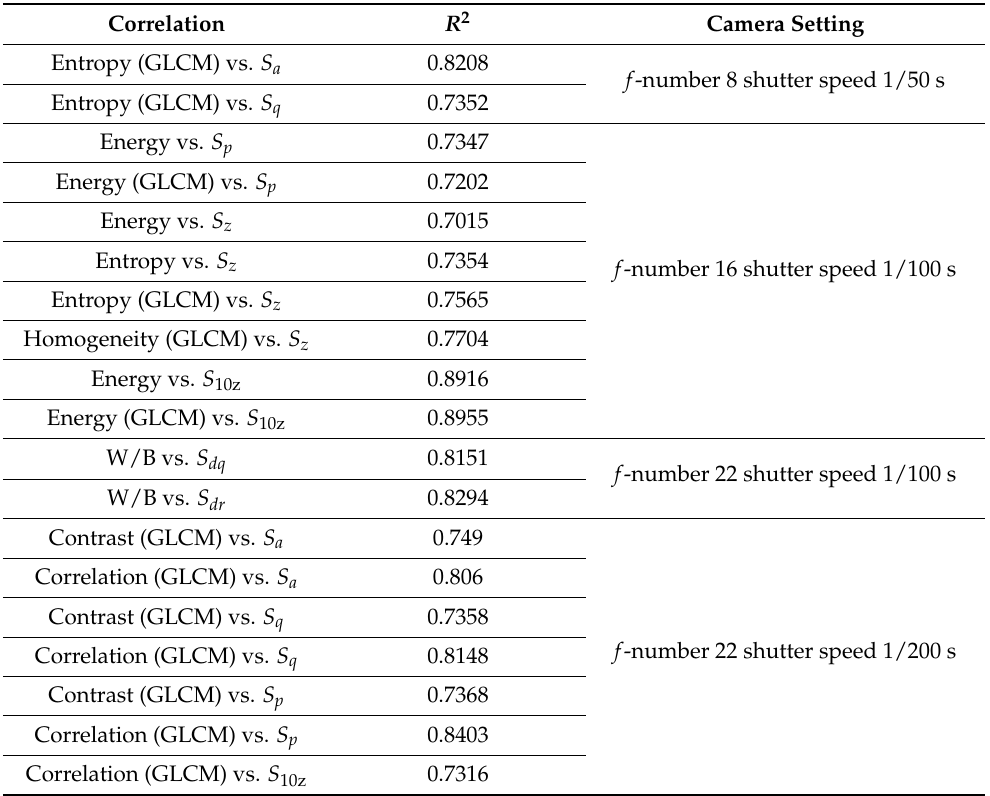
Table 3. Tabulation of coefficient of determination value of more than 0.7 for Illumination angle of 45 ◦